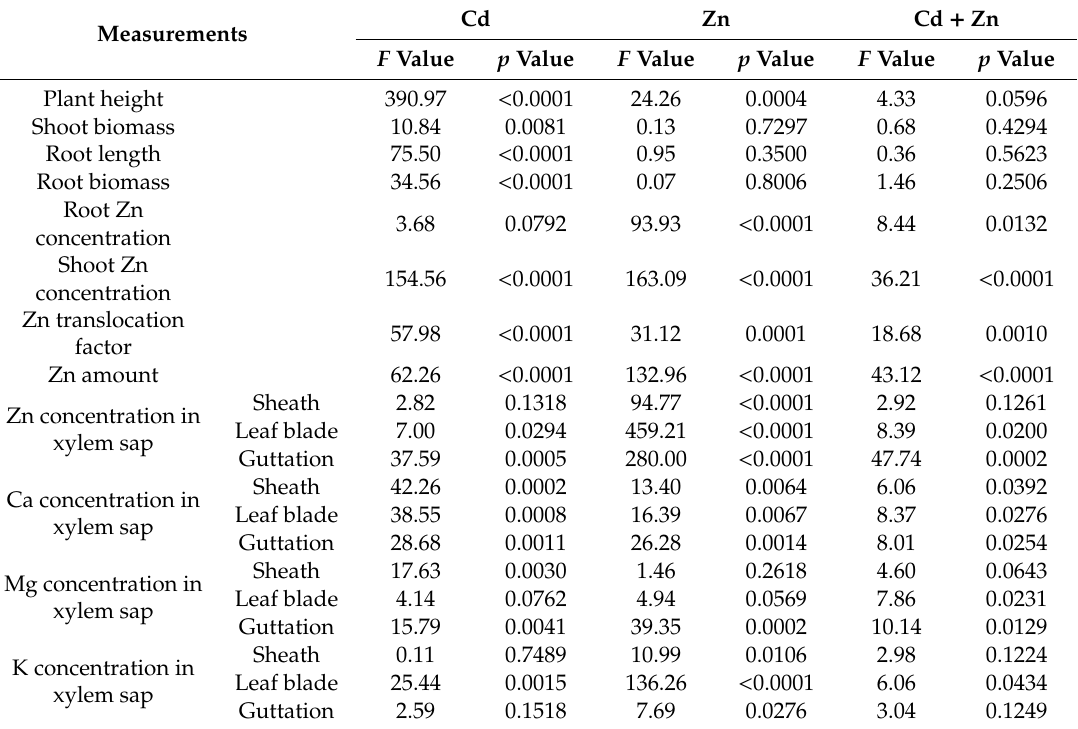
Table 1. Significant levels of Cd and Zn treatment e ff ects and their interactions on plant growth and metal concentrations in tall fescue grown for 15 days in solutions under control (0 µ M Cd + 15 µ